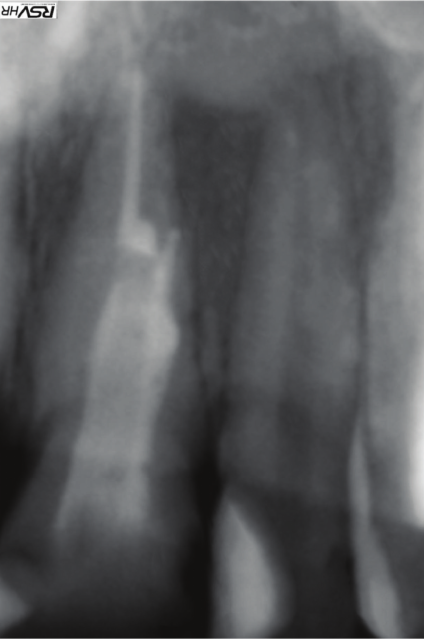
Figure 9: Radiograph at 1-year